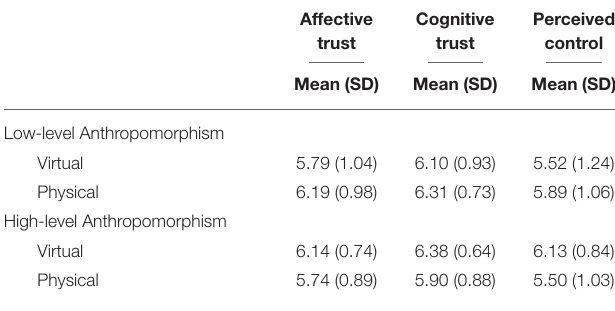
TABLE 1 | Results of two-way